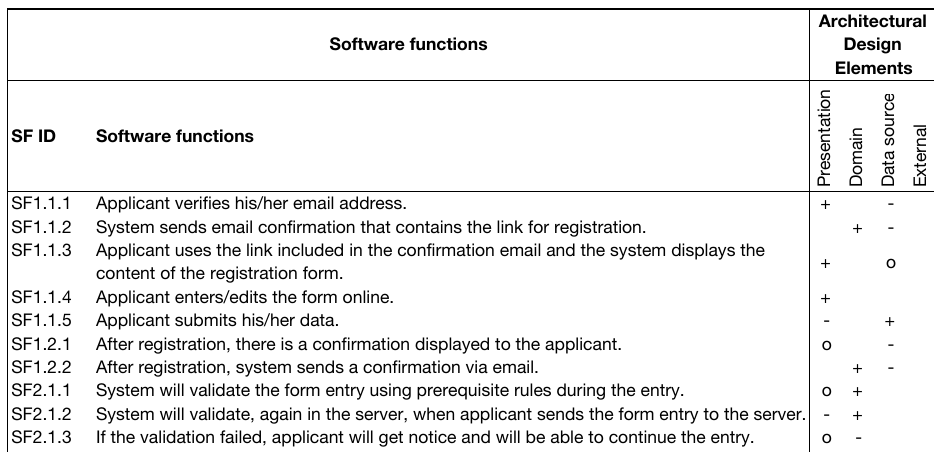
Table 5. Deployment of the software functions to the architectural design elements